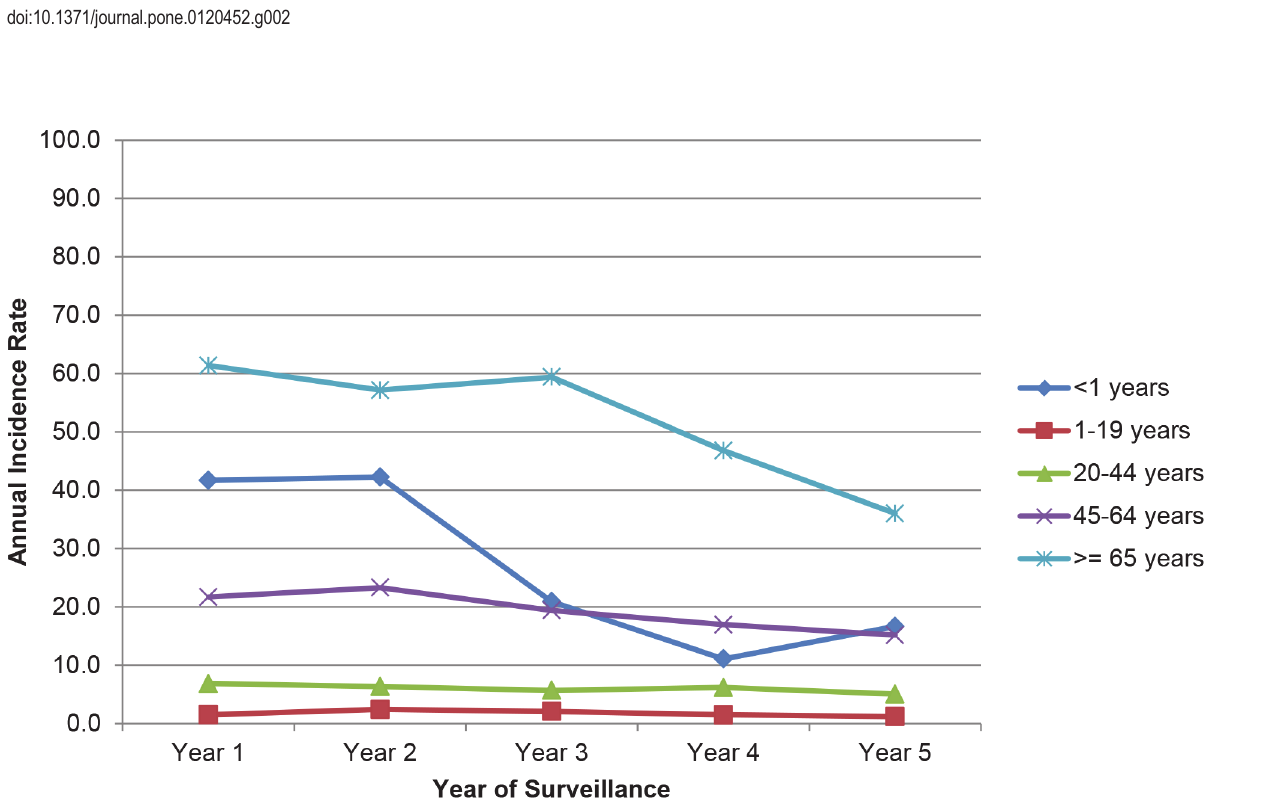
Fig 3. Annual candidemia incidence rates per 100,000 person-years, by year and age-group in the Metropolitan Atlanta area.